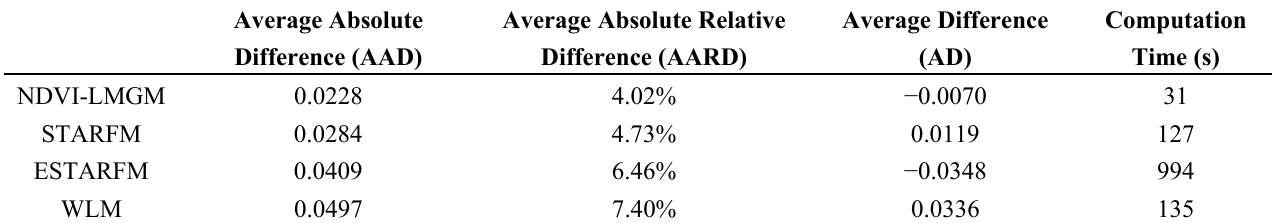
Figure 8. The predicted NDVI images from four methods: ( a ) NDVI-LMGM, ( b ) ESTARFM, ( c ) STARFM, ( d ) WLM, compared to the actual NDVI image ( e ) on 11 July 2001. Table 1. Average Absolute Difference (AAD), Average Absolute Relative Difference (AARD), and Average Difference (AD) between the predicted NDVI values by using the four methods and actual NDVI values directly calculated from a Landsat ETM+ image on 11 July